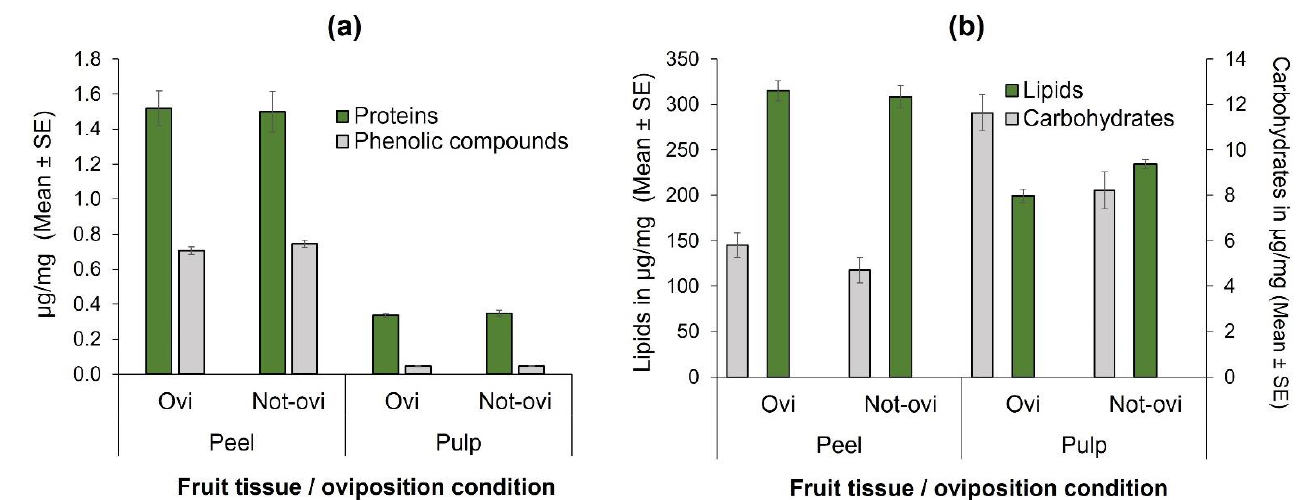
Figure 3. Nutrients quantified ( µ g/mg) according to fruit tissue (peel or pulp) and condition (with eggs [=Ovi] or free of them [Not-ovi]) in “ Criollo ” mango fruit: ( a ) Total phenolic compounds and total protein concentrations; ( b ) Total lipid and total carbohydrate concentrations. Table 1. Polyphenol concentrations in mango peel and pulp resulting from the “targeted metabolomic analysis of plant phenolic compounds” in fruit not exposed to female oviposition